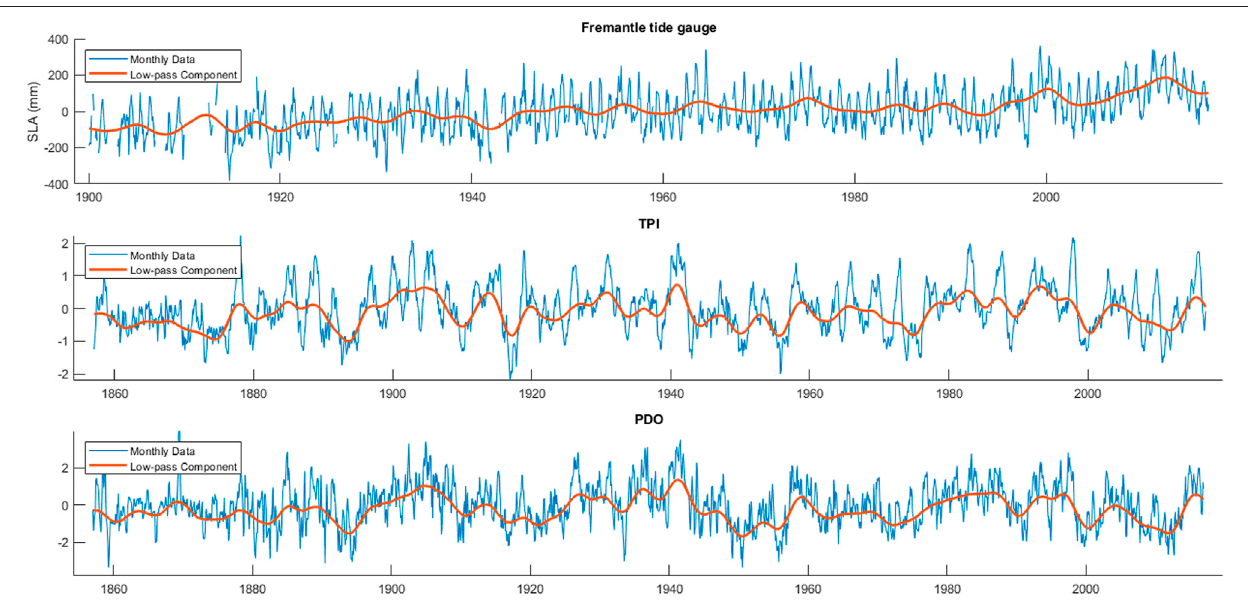
FIGURE 1 | Sea level anomaly in Fremantle (top panel) , Tripole Index for the Interdecadal Paci fi c Oscillation (TPI, middle panel) , and Paci fi c Decadal Oscillation (PDO, bottom panel) data sets and their low-passed time series. The low pass fi lter are the result of two consecutive boxing fi lter with sizes of 25 and 36 months. The fi ltering is applied to remove seasonal and interannual